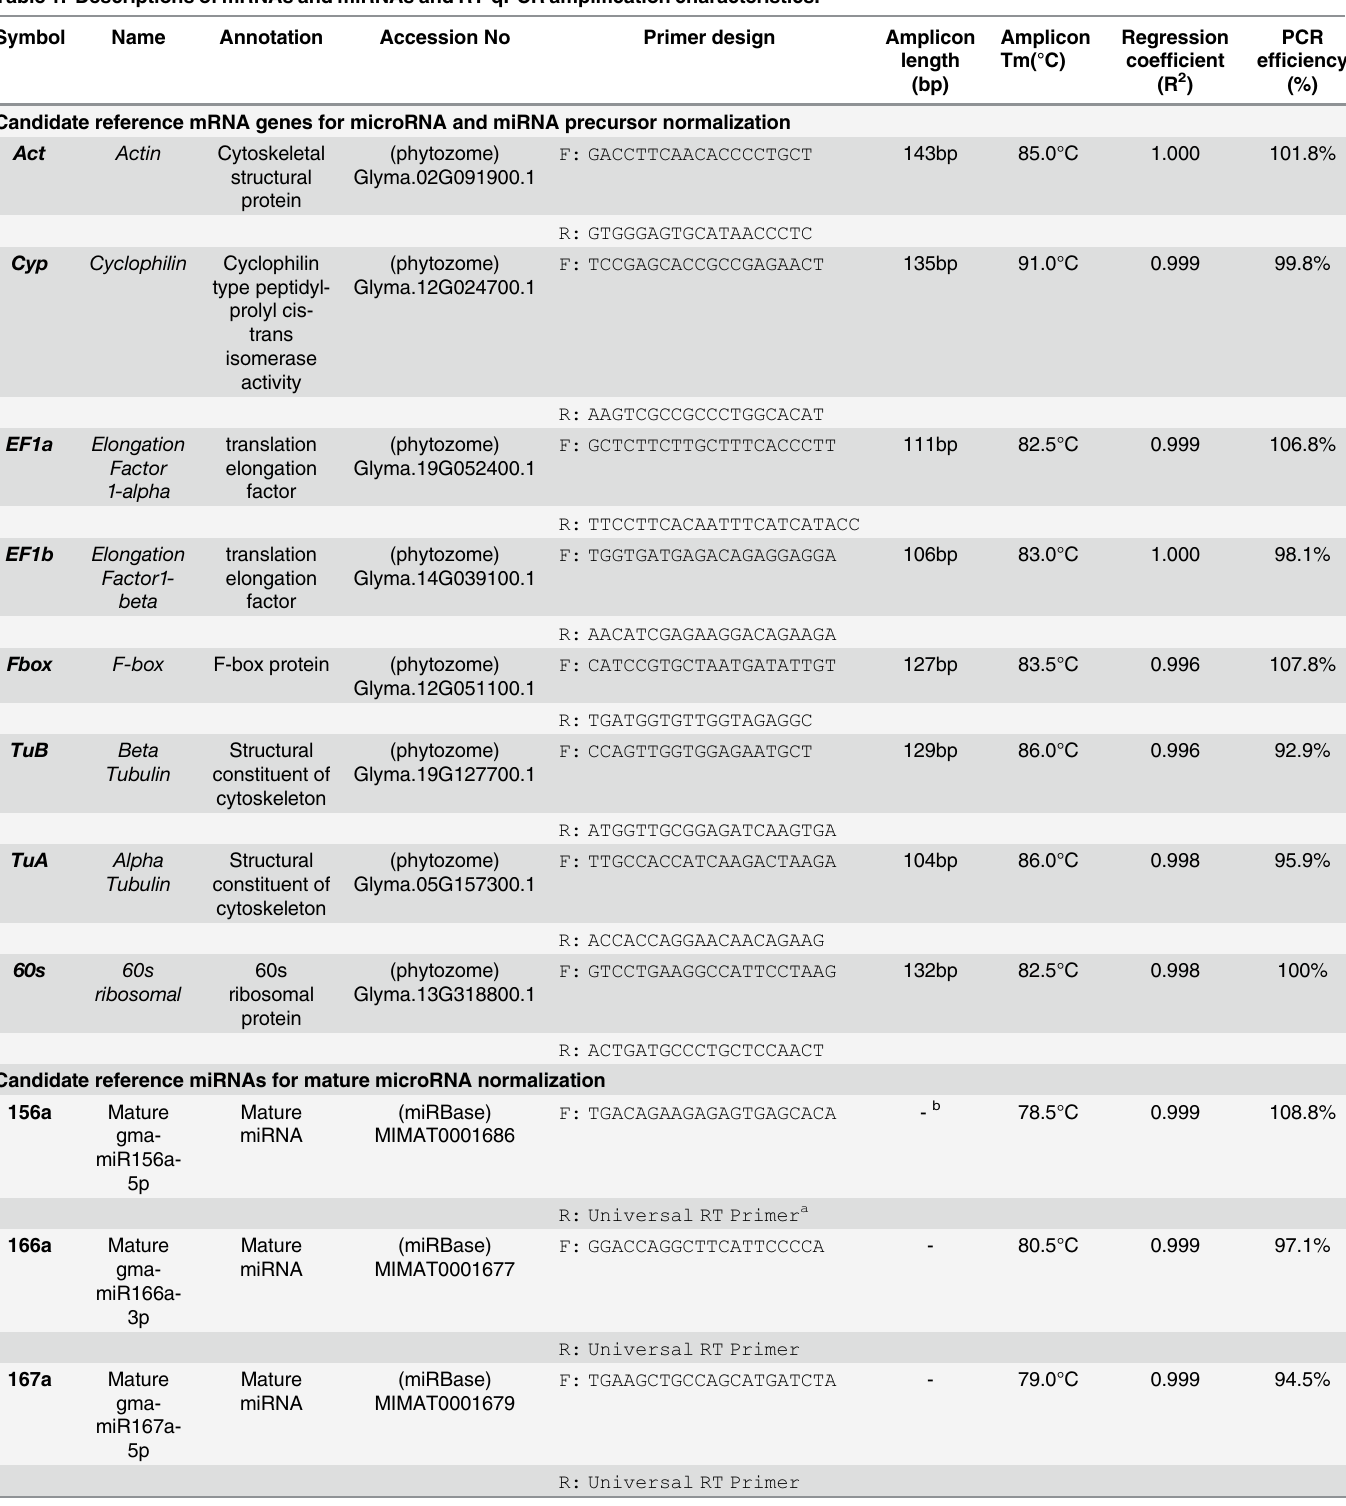
Table 1. Descriptions of mRNAs and miRNAs and RT-qPCR amplification